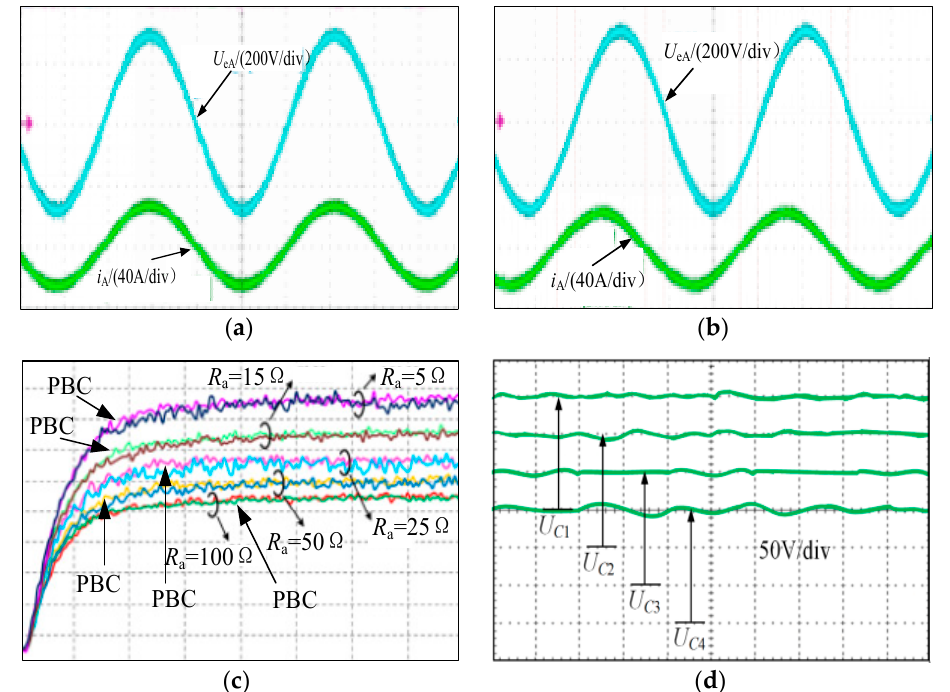
Figure 8. Comparison of hardware experiments under two strategies; ( a ) A-phase grid-connected voltage and current under a PBC strategy; ( b ) A-phase grid-connected voltage and current under the traditional PI control strategy; ( c ) The d -axis current of different injection dampings under the two control strategies; and ( d ) The polar film capacitor voltage under a PBC strategy.